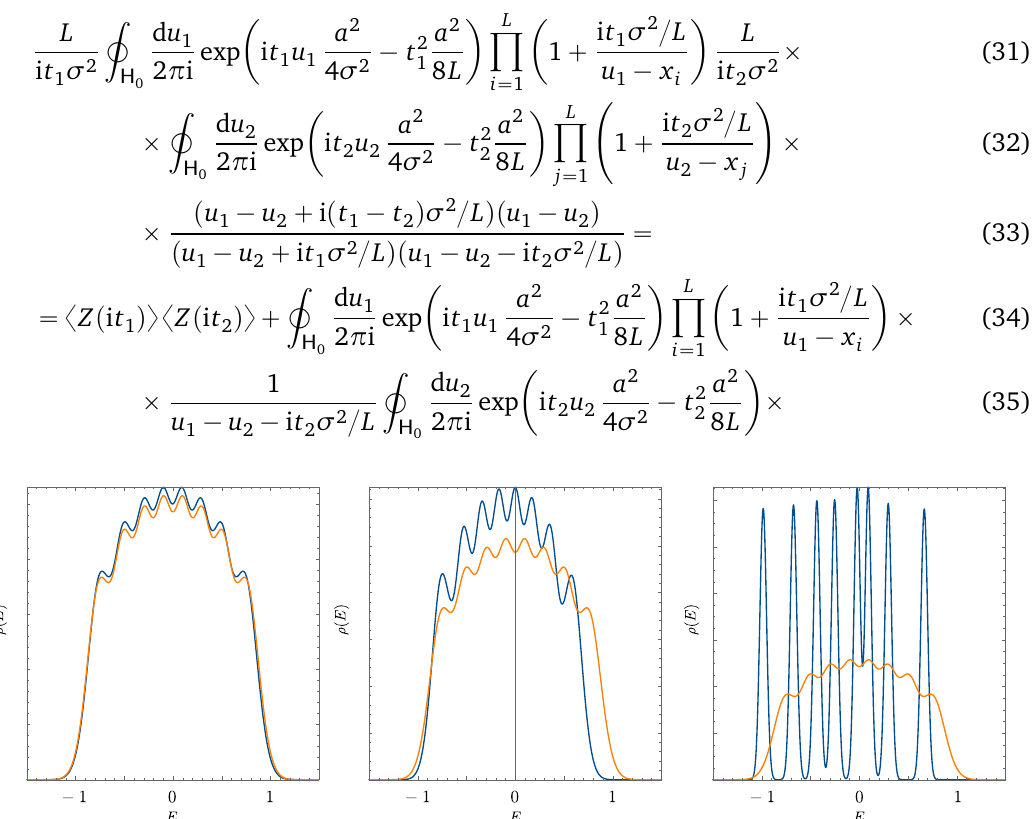
Figure 2: Spectrum ρ p E q for L “ 8 and σ “ 3,1 { 2,1 { 10 (left to right); it transitions from the semicircle (orange) to a sum of deltas on the eigenvalues of H mediate values of σ there are heavy oscillations. The sharper the peaks and valleys in the spectrum, the less random the matrix